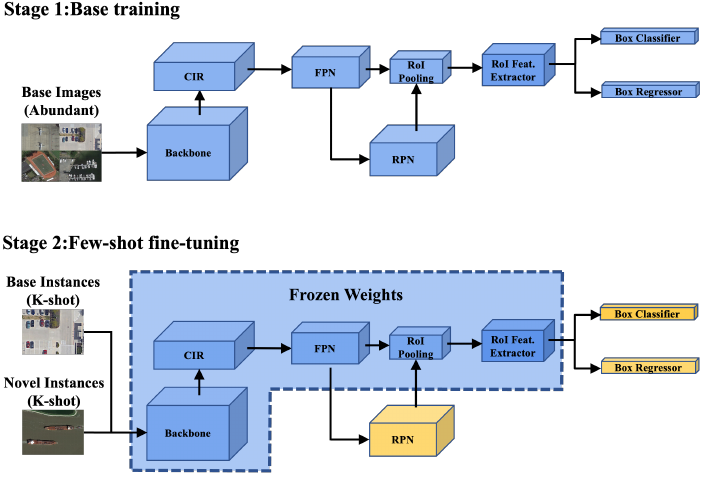
Figure 1. The overview architecture of the proposed few-shot RSI object